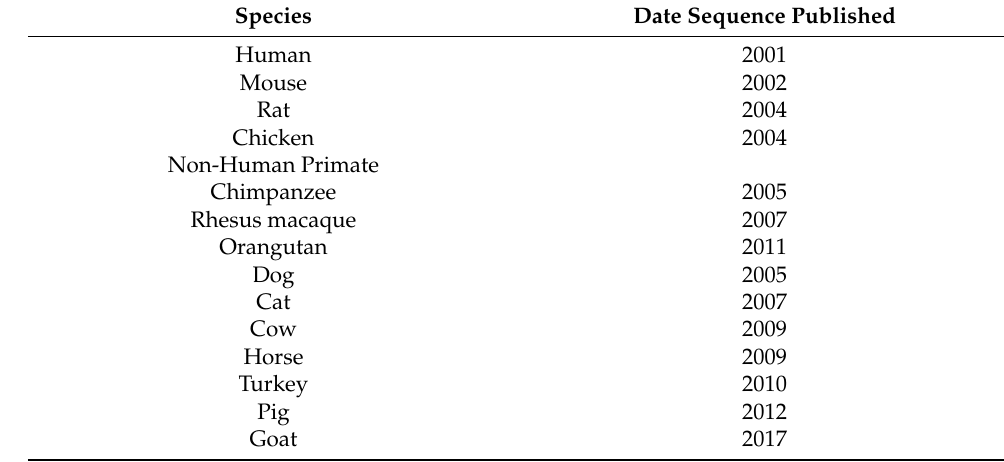
Table 1. Timeline of animal genome sequencing